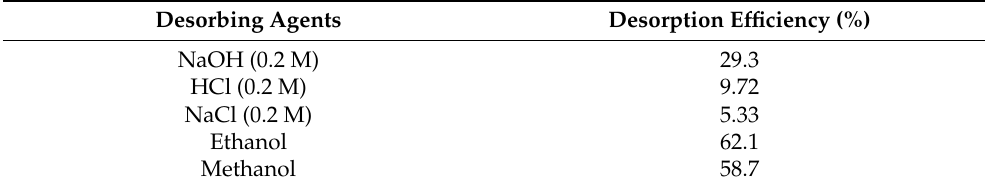
Table 3. Desorption efficiency of AC from laden N-SC/ β -CD-MOFs using different desorbing